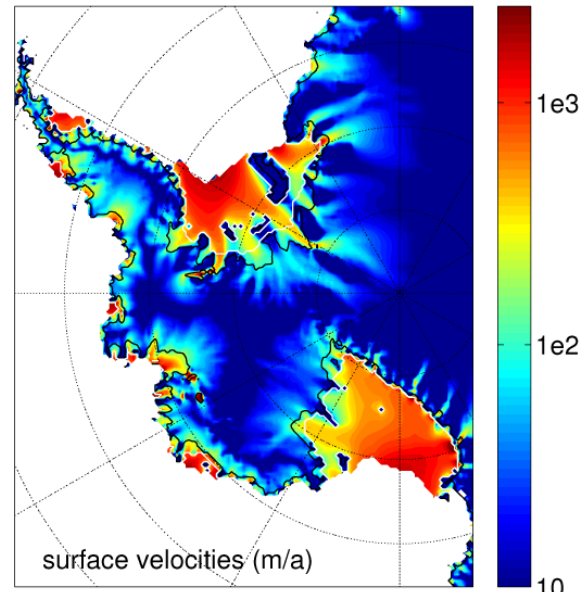
Fig. 10. Modeled surface velocity for the West Antarctic Ice Sheet. White lines show the grounding-line position, thin black lines indi- cate ice streams according to inequality Eq. (6).